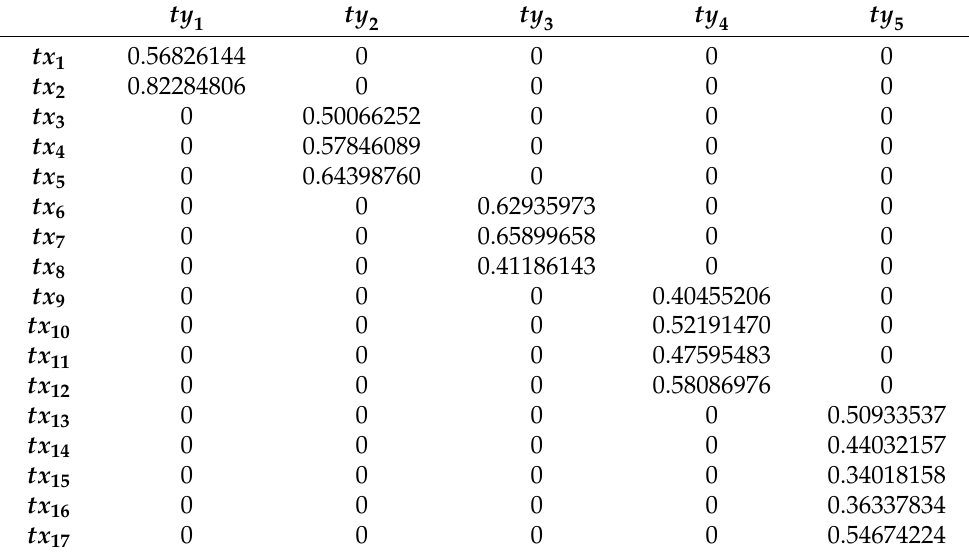
Table 17. Loading matrix C with DisjointTuckerALS algorithm for simulated data.